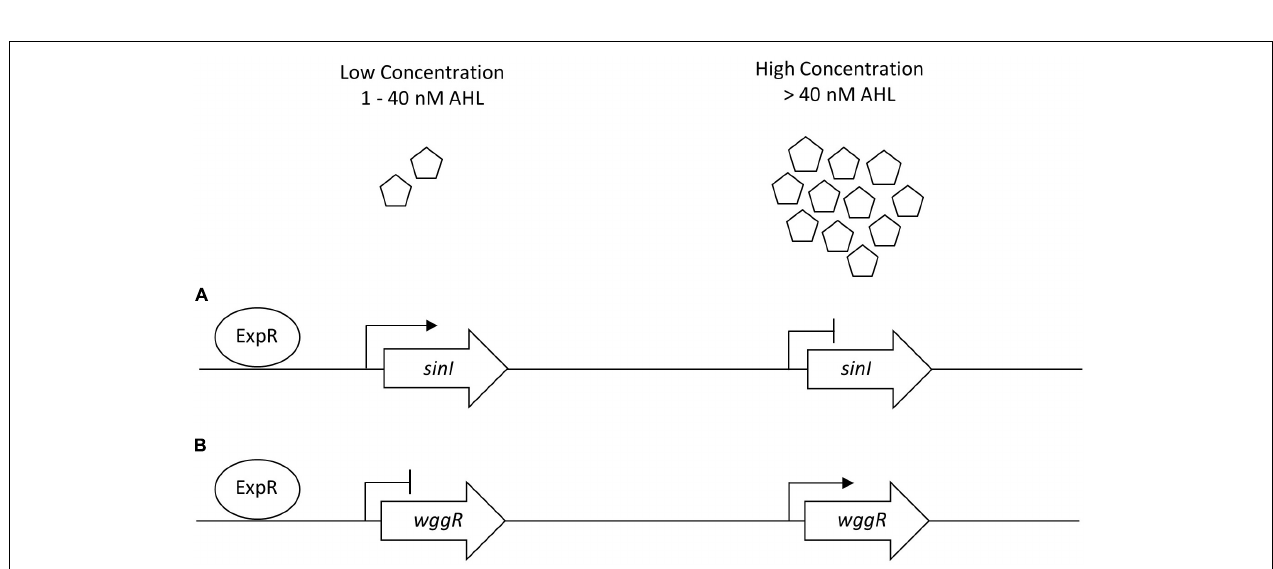
FIGURE 6 | Generalized sinI /ExpR quorum sensing transcription model for sinI and wggR . Expression of genes are controlled on multiple levels including length of AHL chain and AHL concentration. (A) Low concentrations of AHL (1–40 nM) upregulate sinI expression in a positive feedback regulation. (B) Low concentrations of AHLs downregulate wggR expression. Adapted from Baumgardt et al. (2014).